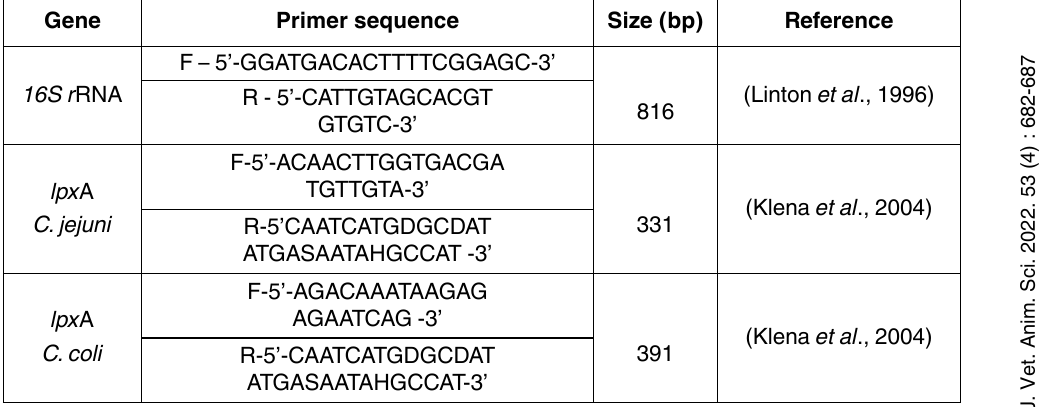
table 2. Primers used for the identification of Campylobacter spp.